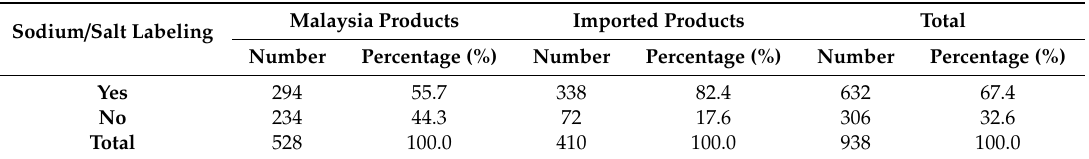
Table 2. Number and percentage of processed food products manufactured in Malaysia and imported with and without labeling of sodium or salt.